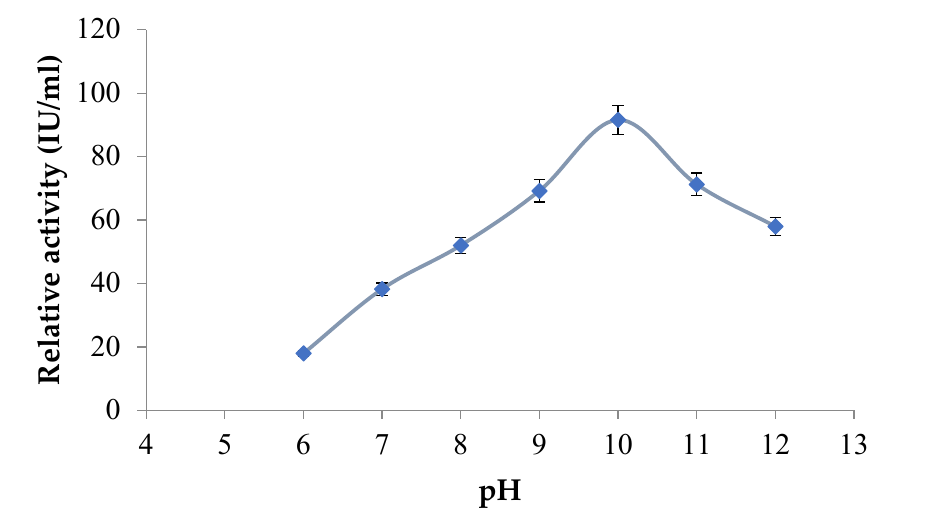
Figure 3. Effect of pH on protease activity.